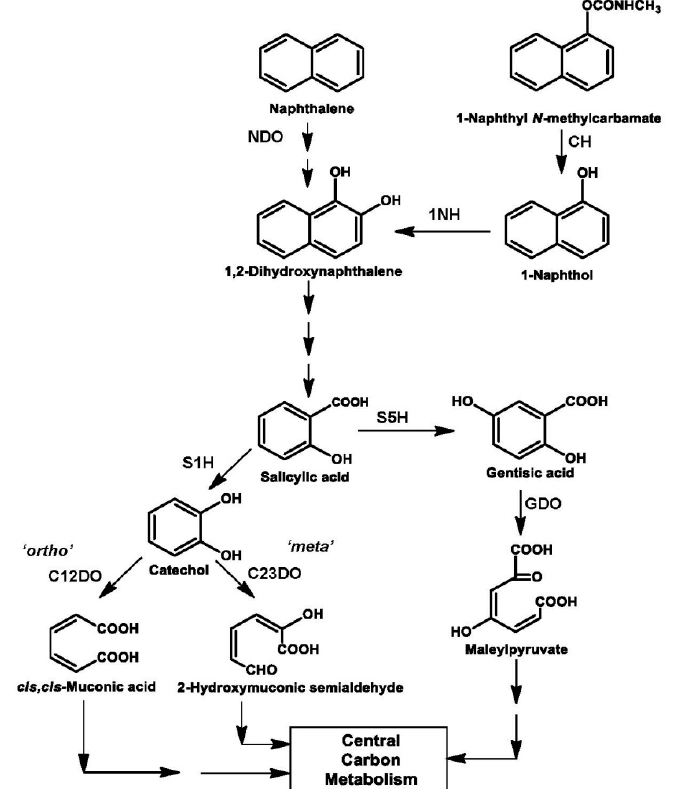
Figure 2. Metabolic diversity observed in naphthalene and Carbaryl degradation pathways from soil bacterial isolates. Abbreviations are: NDO, naphthalene 1,2-dioxygenase; CH, Carbaryl hydrolase; 1NH, 1-naphthol 2-hydroxylase; S1H, salicylate 1-monoocxygenase; S5H, salicylate